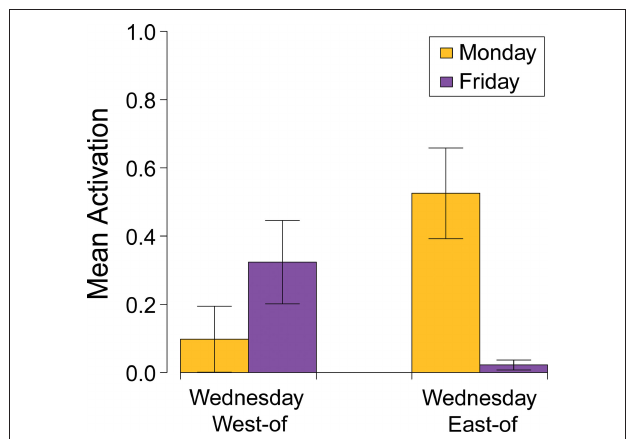
Figure 4 | The results of Simulation 2 showing that spatial relations that were never directly experienced in the temporal domain can still structure temporal reasoning.